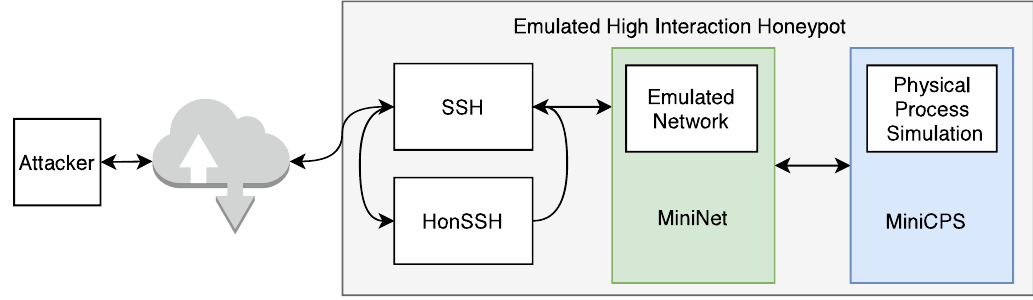
Figure 8. Diagram of honeypot testbed.